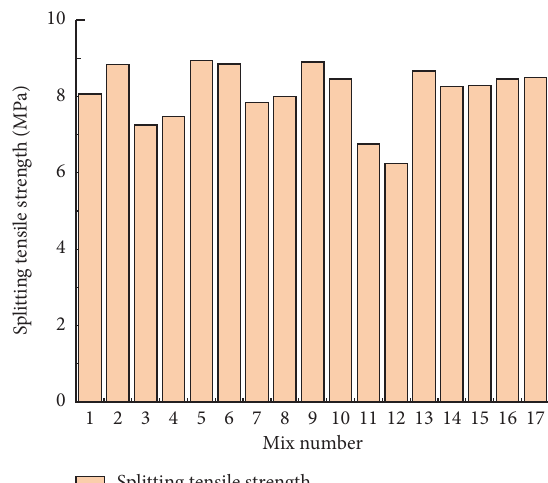
Figure 9: Splitting strength under different mix ratios.